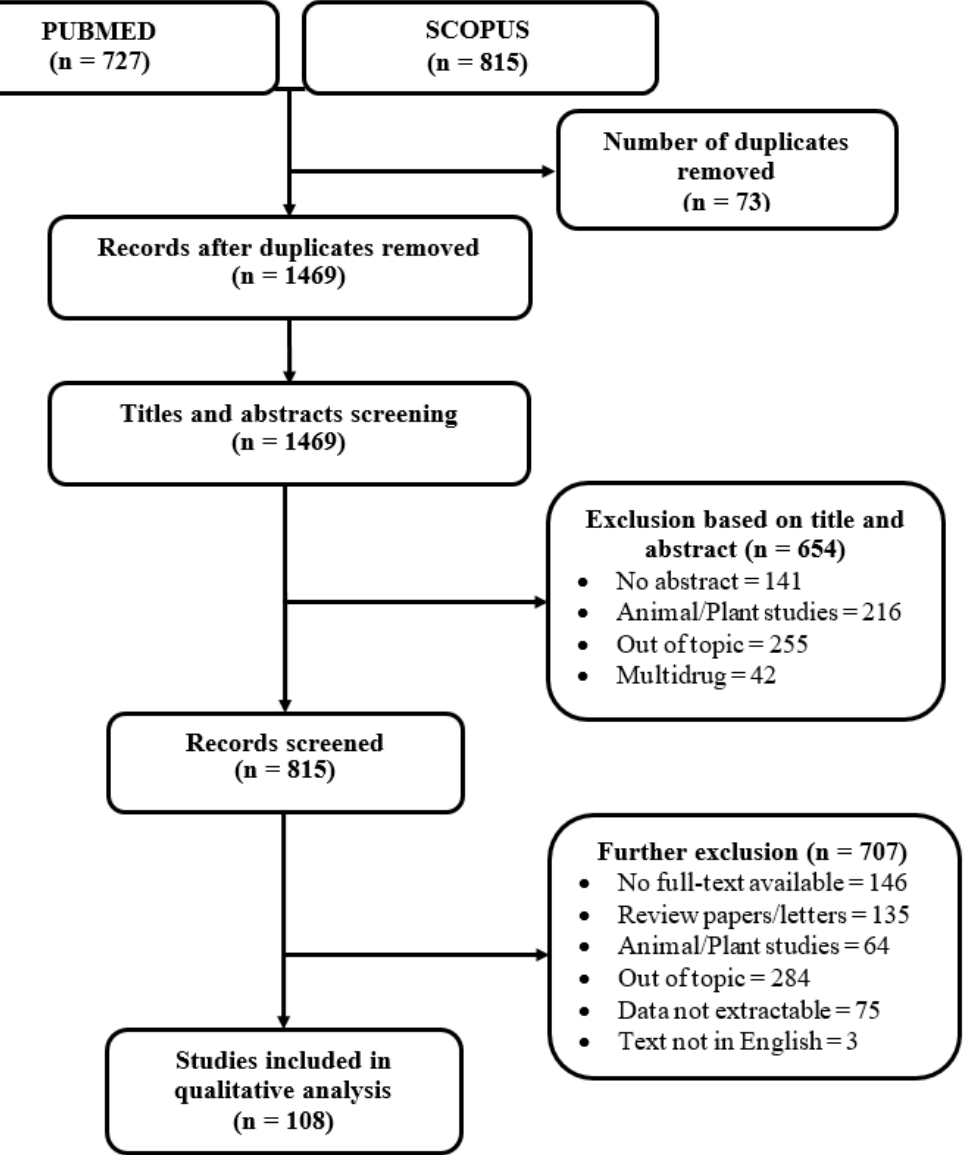
Figure 1. PRISMA flow chart.